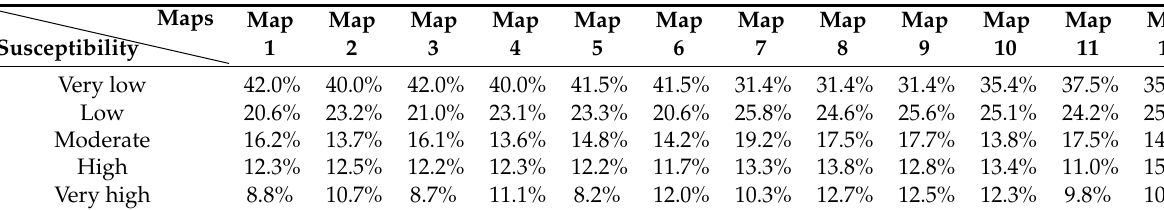
Table 7. The classification distribution table of the susceptibility map of geological disasters.